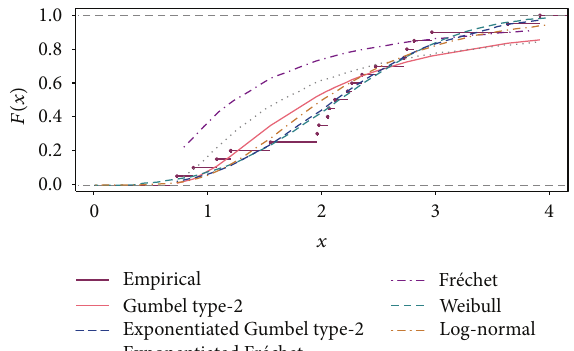
Figure 3: cdf plots of the fitted distributions superimposed on the empirical density plot of the survival times